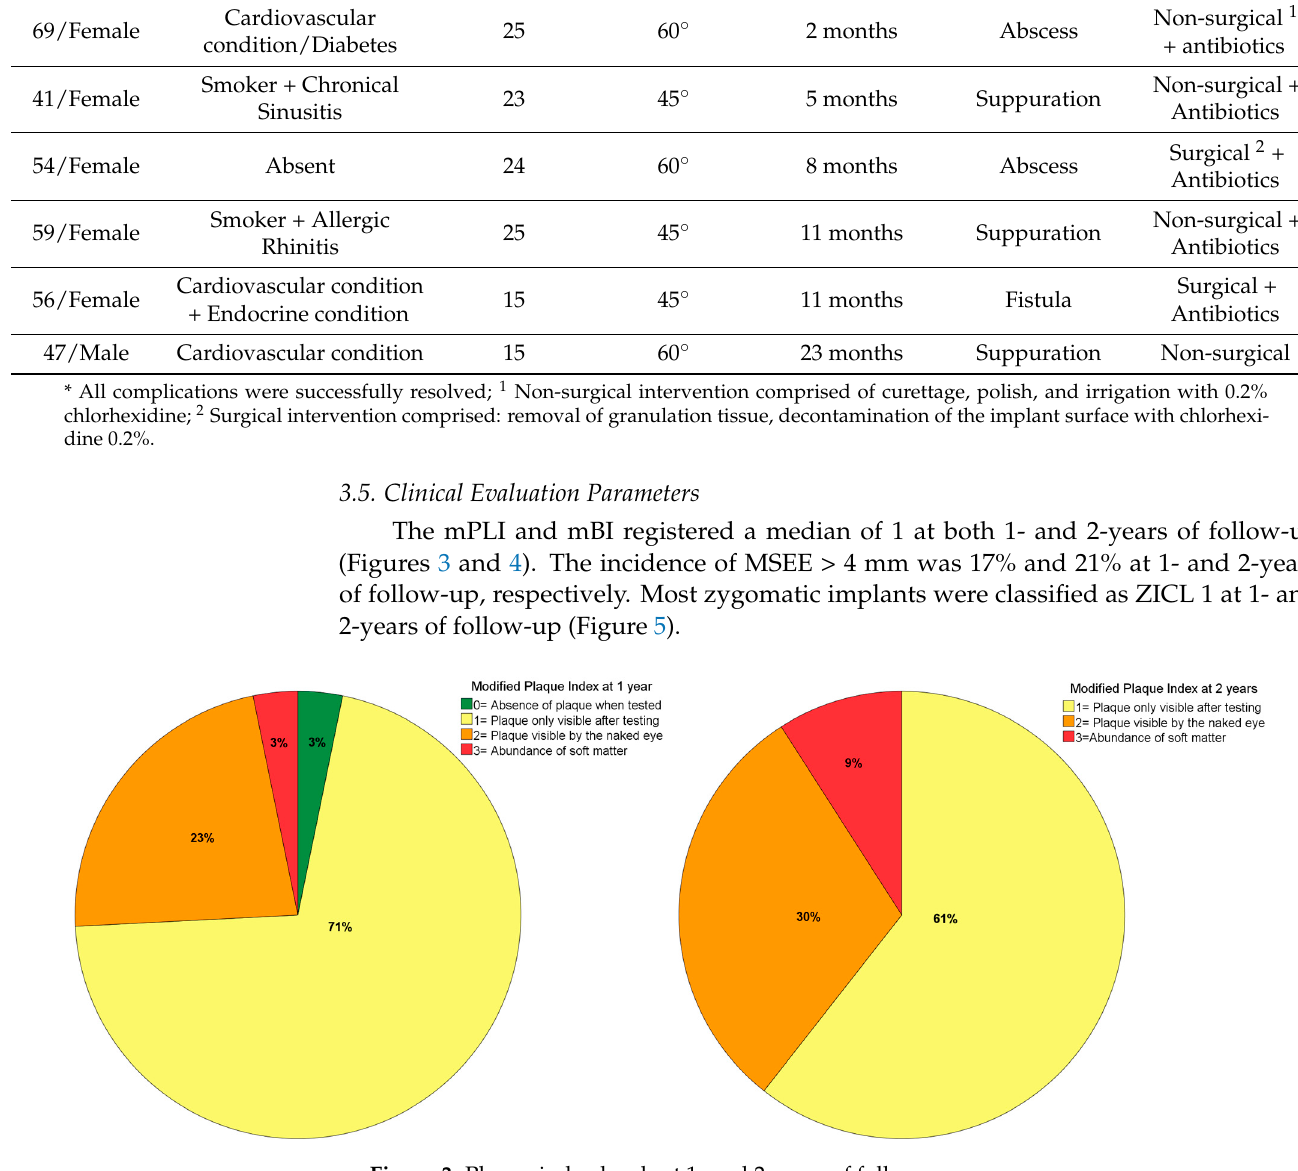
Figure 4. Modified bleeding index levels at 1- and 2-years of follow-up.